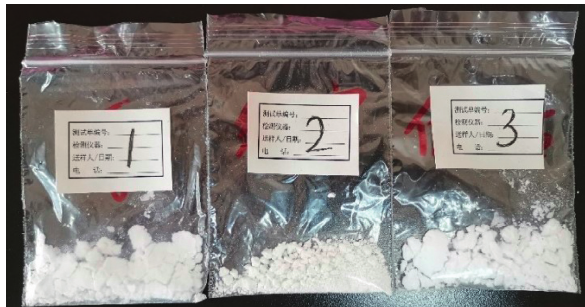
Figure 10: Microscopic test